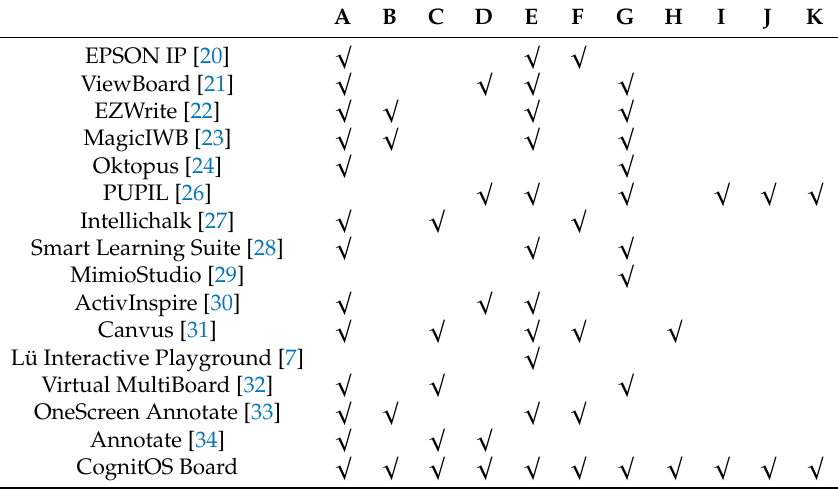
Table 2. Comparison matrix of Interactive Board